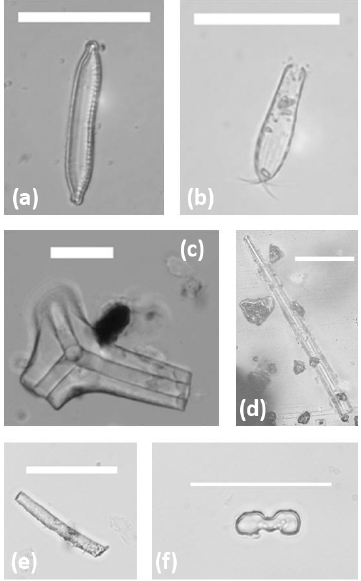
Figure 2. Micrographs (light microscope) of biogenic silica struc- tures found at Chicken Creek. (a) Pennate diatom (valve view), (b) testate amoeba shell ( Euglypha cristata ), (c) and (d) sponge spicules (fragments), (e) elongate phytolith and (f) bilobate phy- tolith. All scale bars: